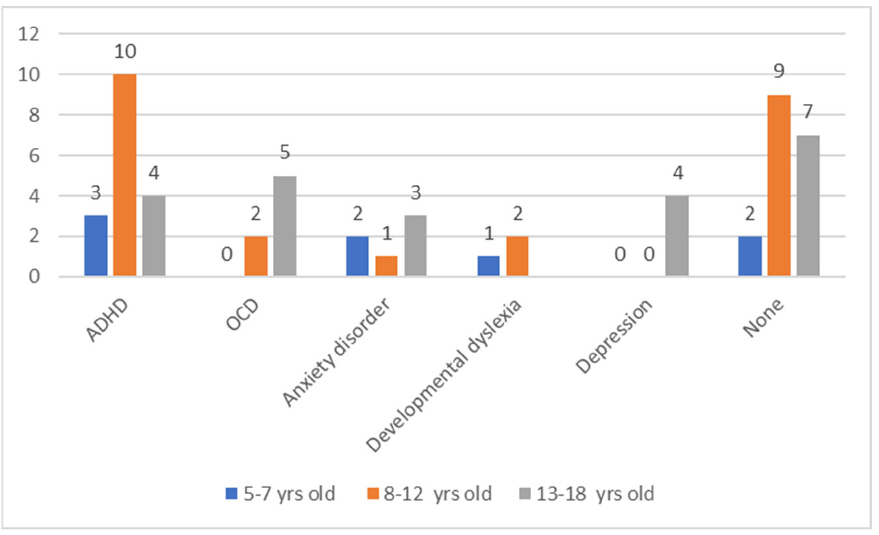
Figure 2. Comorbid conditions. ADHD—Attention ‐ Deficit/Hyperactivity Disorder; OCD—Obsessive ‐ Compulsive Disorder.